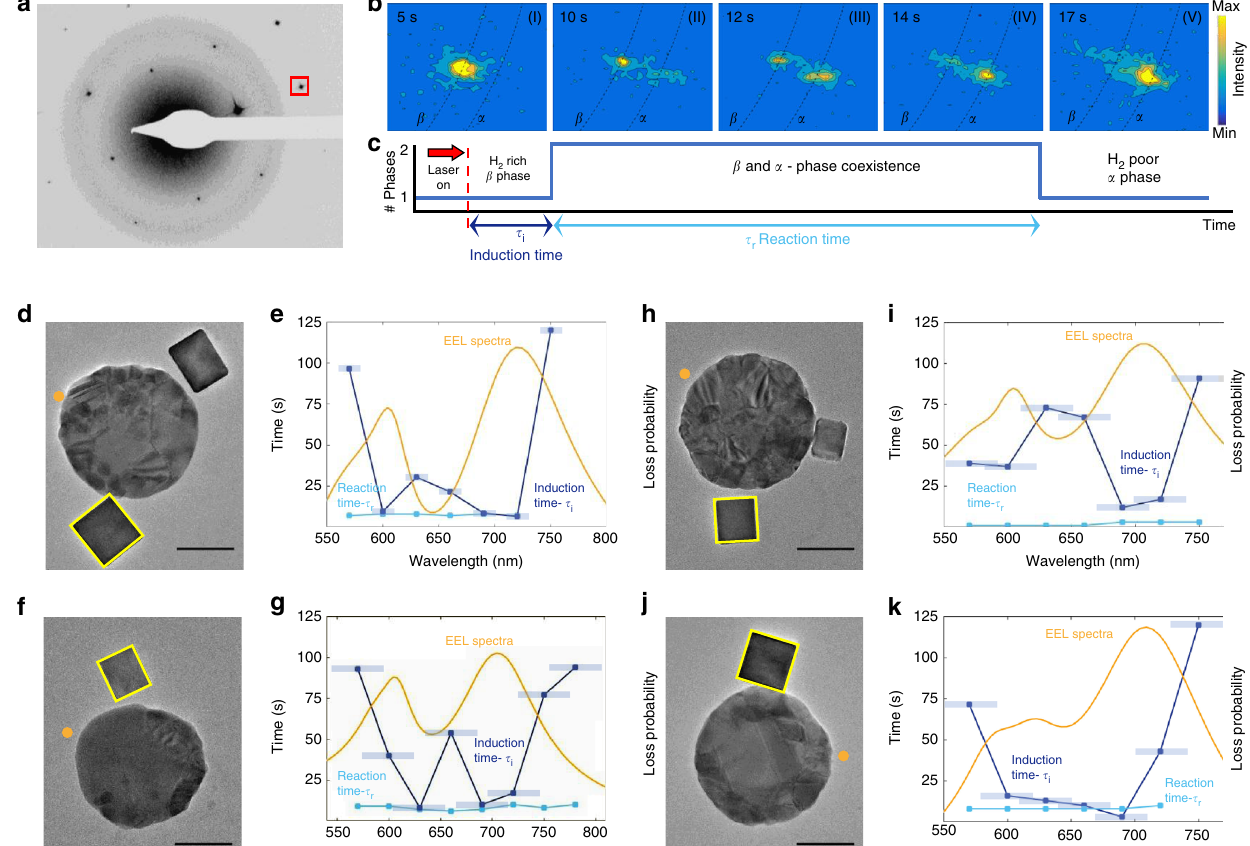
Fig. 2 Wavelength dependence of the two reaction steps. a An electron diffraction micrograph of a single Pd nanocube shown in f . The highlighted 400 diffraction spot is monitored for the analysis of the evolution of the phase transformation reaction shown in b . b Time snapshots of a zoomed-in diffraction spot showing the emerging α phase and the vanishing β phase upon illumination. The black dotted lines correspond to the arc delineating constant lattice parameter (see Supplementary Fig. 1 as well). c A timeline describing the evolution of the phase transformation reaction with the two characteristic time constants, the induction time and the reaction time. d , f , h , j Transmission electron microscope images of four antenna-reactor pairs with highlighted Pd cubes for which the wavelength dependence analyses appear in e , g , i and k . Scale bars are 50 nm. e , g , i , k Wavelength dependence of the induction time constant (dark blue) and the reaction time constant (light blue). The error bars correspond the bandwidth of the laser. Simulated EEL spectra are shown in orange with an electron beam impact position marked with a dot in the corresponding TEM